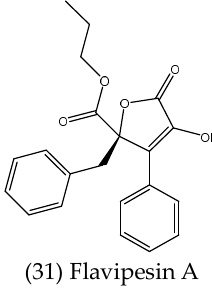
Figure 7. Structures of antibiofilm compounds produced by endophytes.